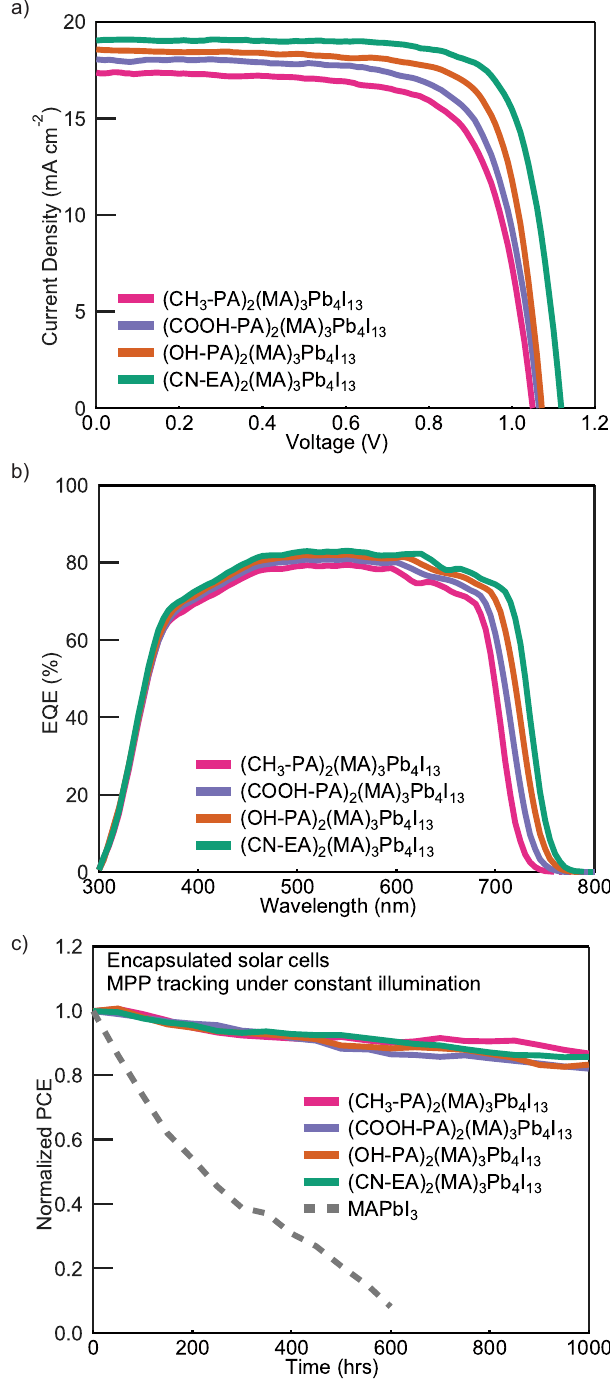
Fig. 4 Device characterization for n = 4 perovskite devices. a J-V characteristics under reverse scan; b External quantum ef fi ciency (EQE) of n = 4 2D perovskite solar cells; and c normalized PCE as a function of operation time of encapsulated 2D perovskite solar cells under continuous illumination at maximum power point (MPP)